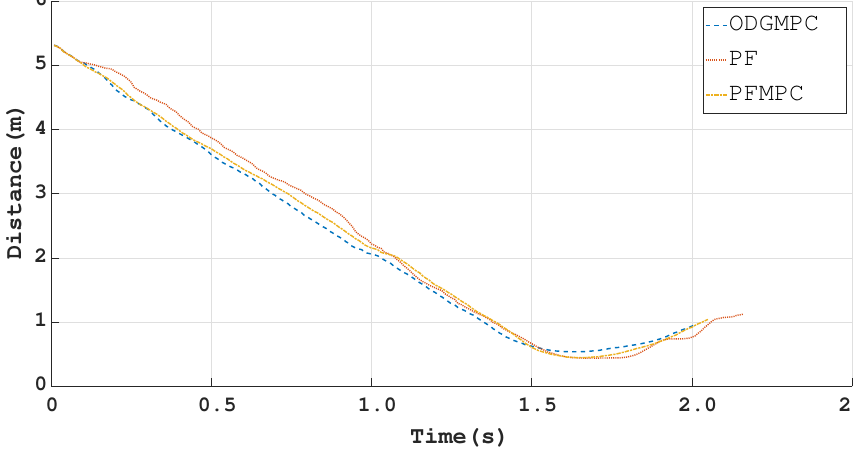
Figure 32. Results of the obstacle distance from Scenario 3 for a static